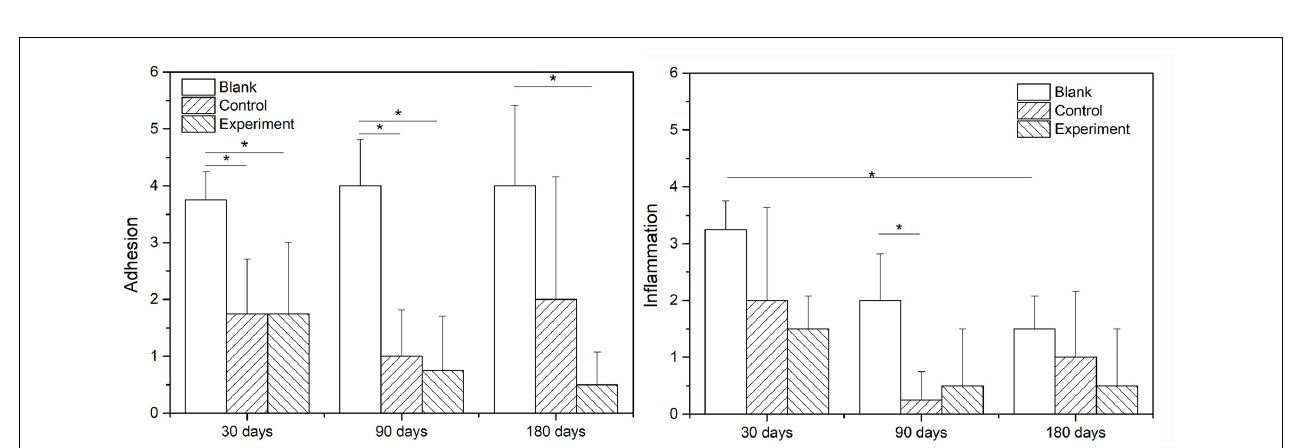
FIGURE 9 | The grade scoring of adhesion and inflammation on microscopic assessment (* P <